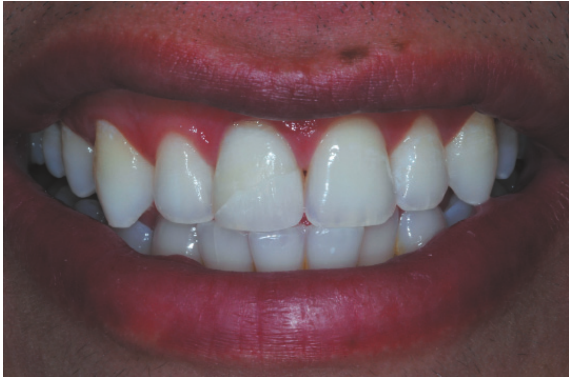
Figure 1- Initial case, showing inadequate reproduction of the polychromatic aspects of tooth